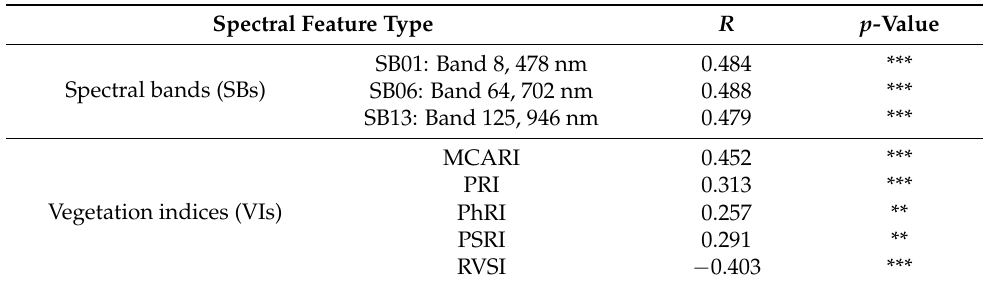
Figure 4. R 2 among different features of each spectral feature type: ( a ) SBs, ( b ) VIs, and ( c ) WFs. Table 2. Optimal spectral features for detecting wheat FHB.